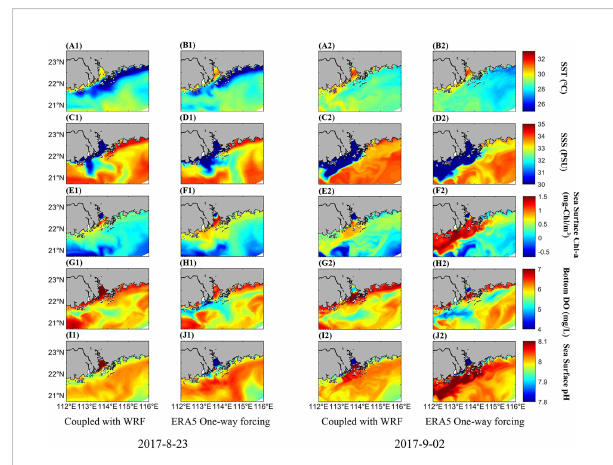
FIGURE 11 Comparison of horizontal distribution of SST, SSS, sea surface chlorophyll, bottom DO, and surface pH between ERA5 one-way atmospheric forcing (A, C, E, G, and I) and WRF two-way forcing (B, D, F, H, and J) . Snapshots were selected during (August 23, 2017) and 11 d (September 02, 2017) after the typhoon.